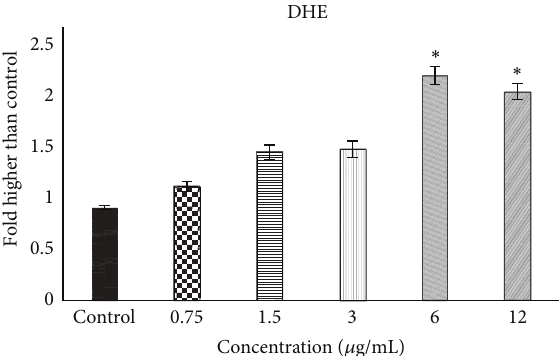
Figure 6: Effect of Cu(BrHAP) 2 on ROS production. After incubation with DMSO or Cu(BrHAP) 2 for 24 h, HT-29 cells were collected, stained with DHE, and subjected to a fluorescence microplate